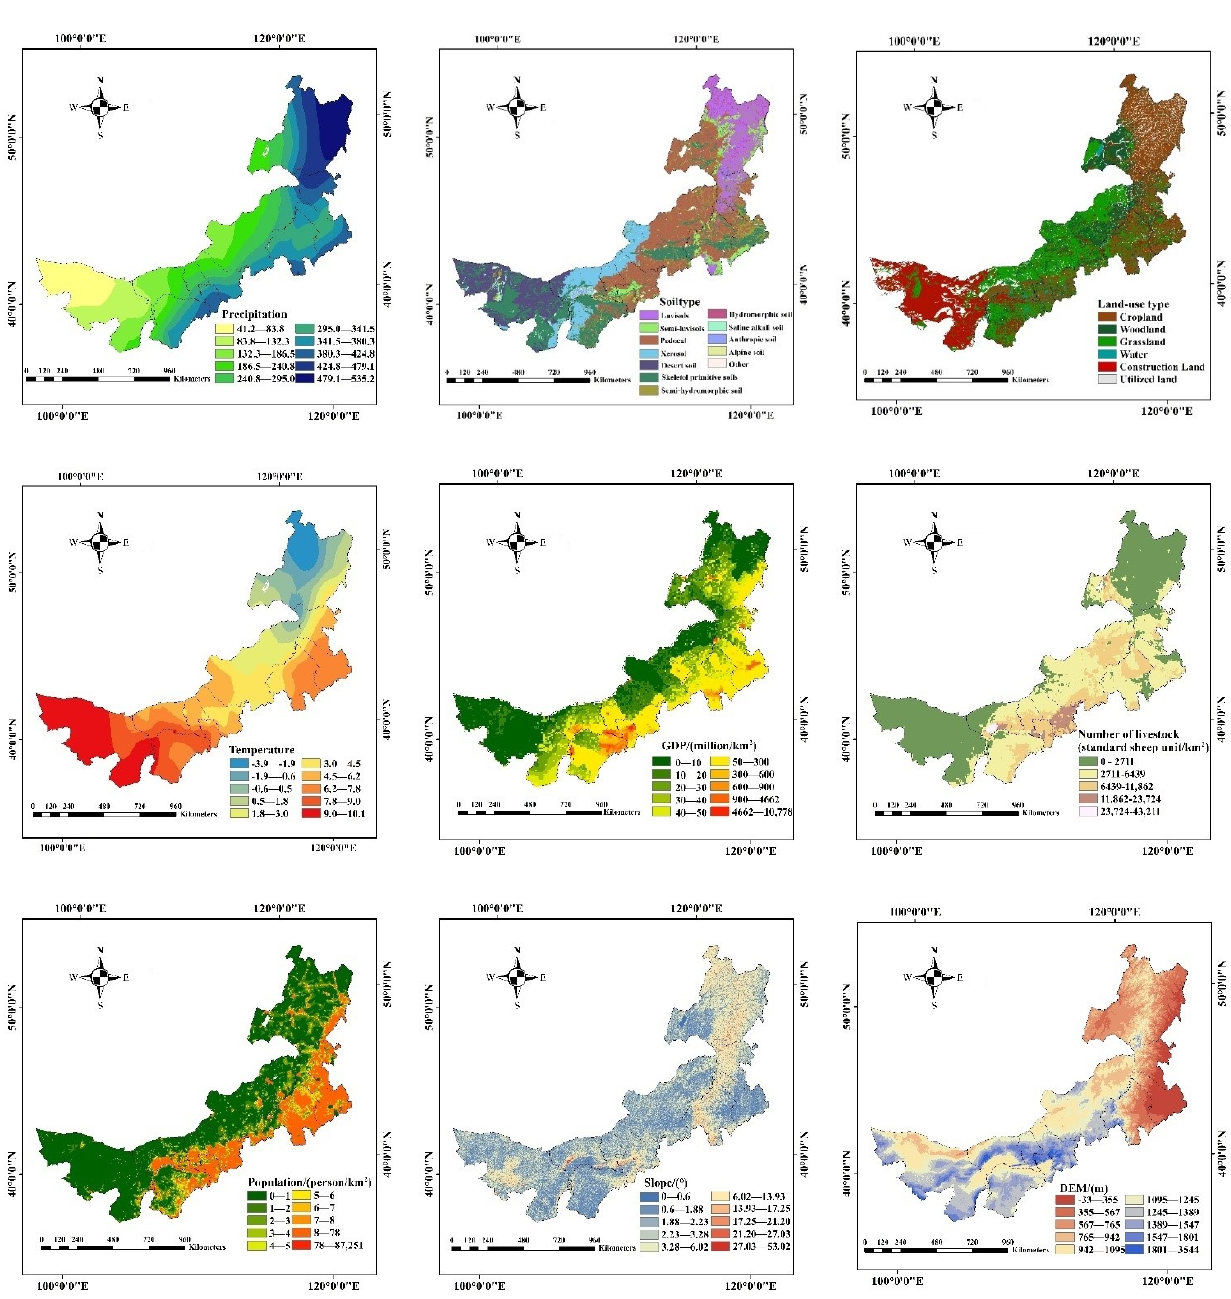
Figure 2. NDVI drivers and spatial distribution in Inner Mongolia.